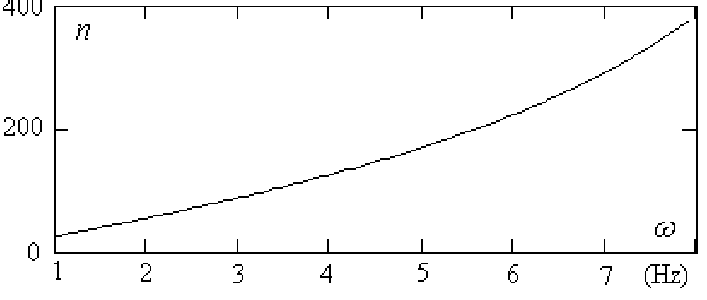
Fig. 2. Dependence of the mode number n on the wave frequency ω for left-hand polarized cyclotron waves ( l =–1) in the hydrogen plasma at magnetic shell L =6.6 with the particle density N e = N c + N h = 11cm − 3 .